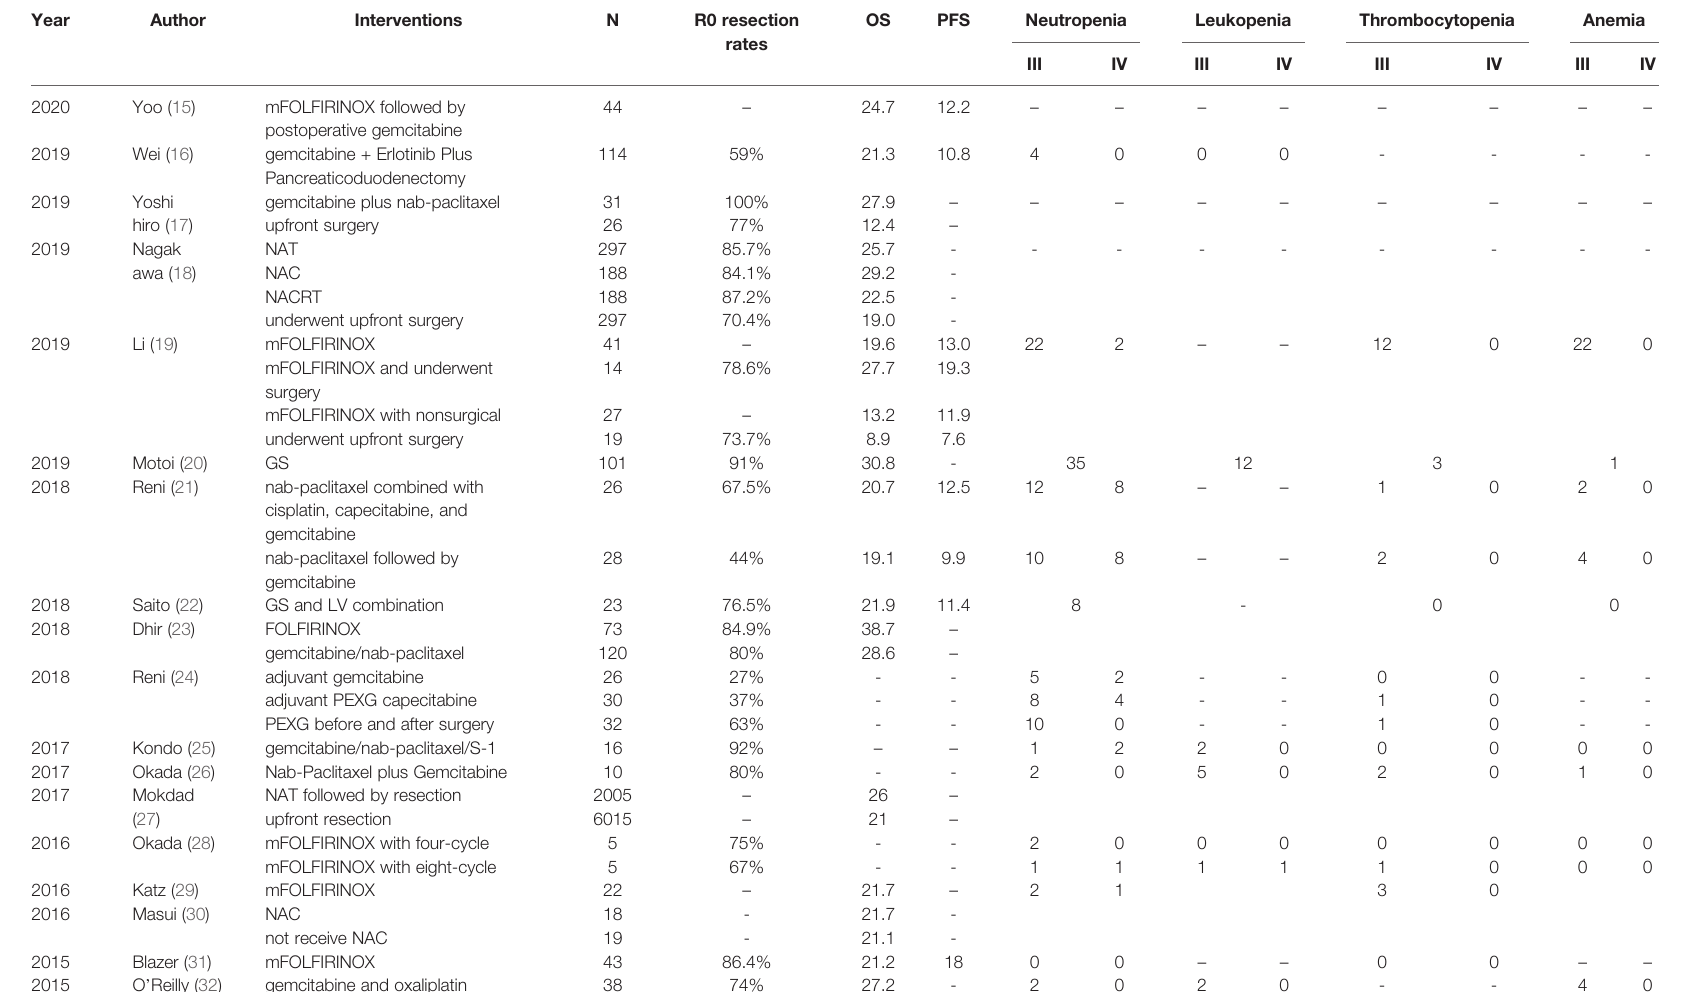
TABLE 2 | Clinical trials with NAC on advanced pancreatic